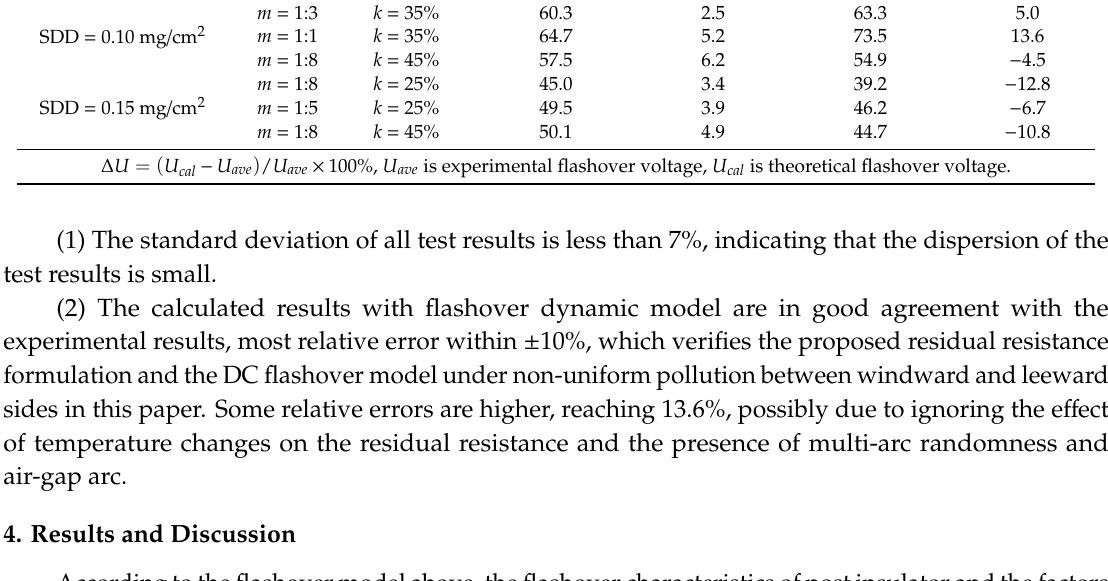
Table 2. Results of validation test. SDD: salt deposit density.